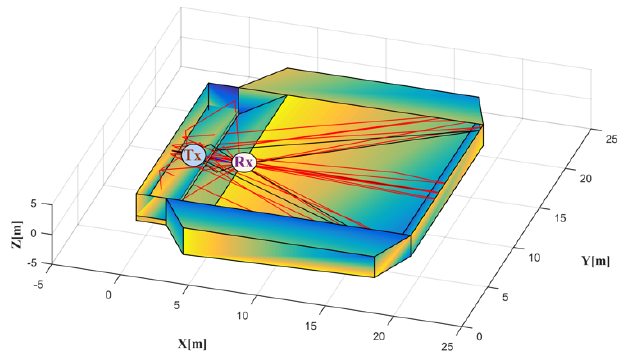
Figure 8. Deterministic mode of the channel model.